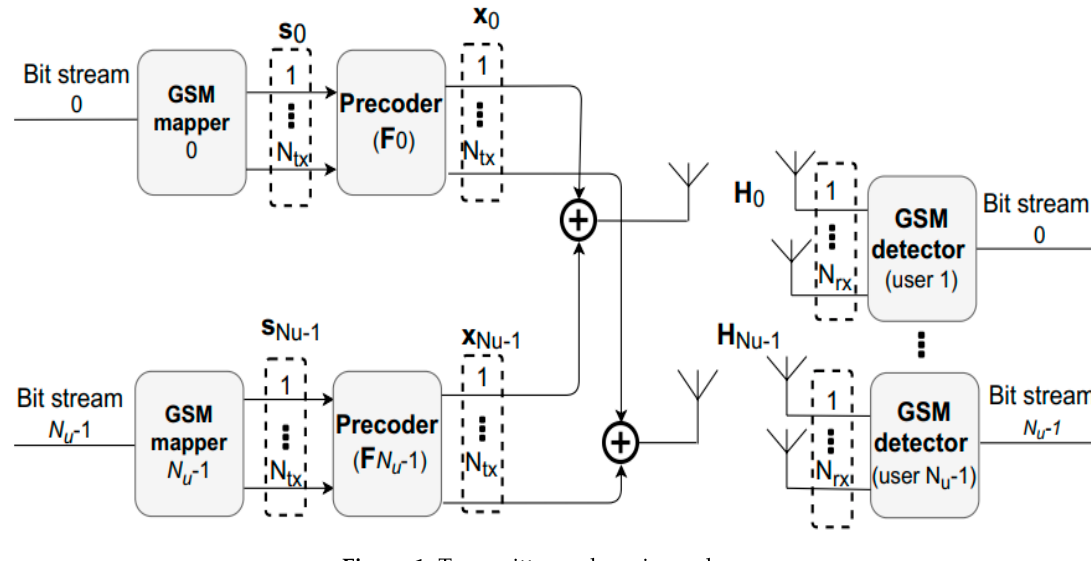
Figure 1. Transmitter and receiver scheme.